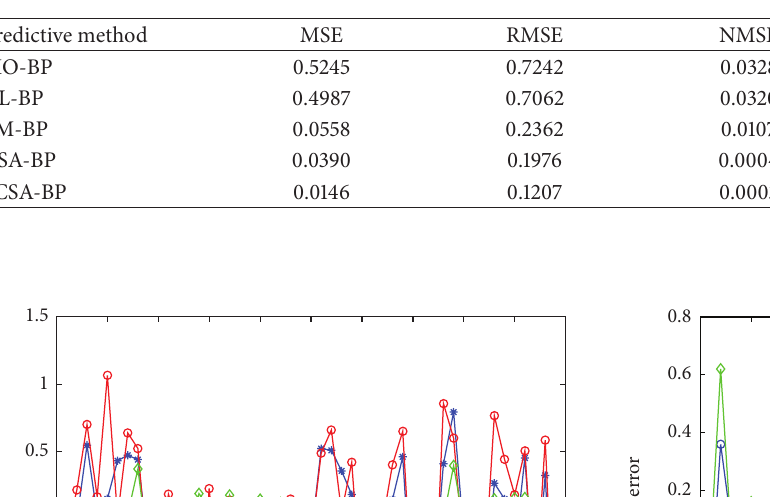
Table 2: Performance comparison under different training methods.